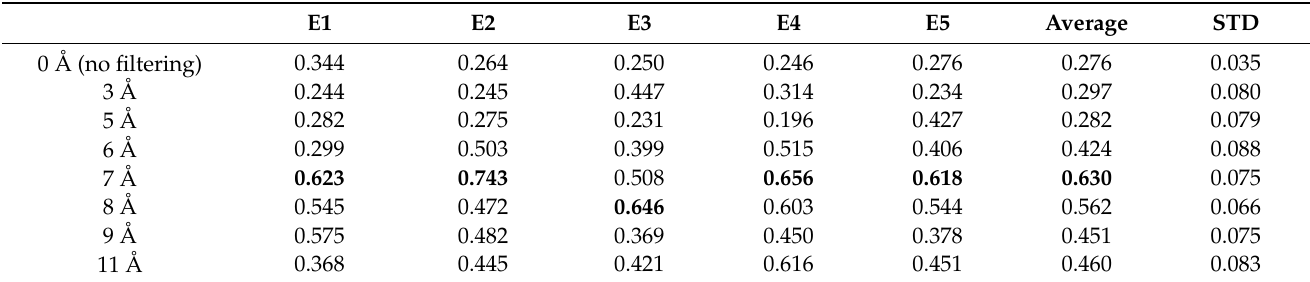
Table 2. Comparison of different spatial filter radiuses. Five independent replicates were performed for each radius to eliminate random errors.